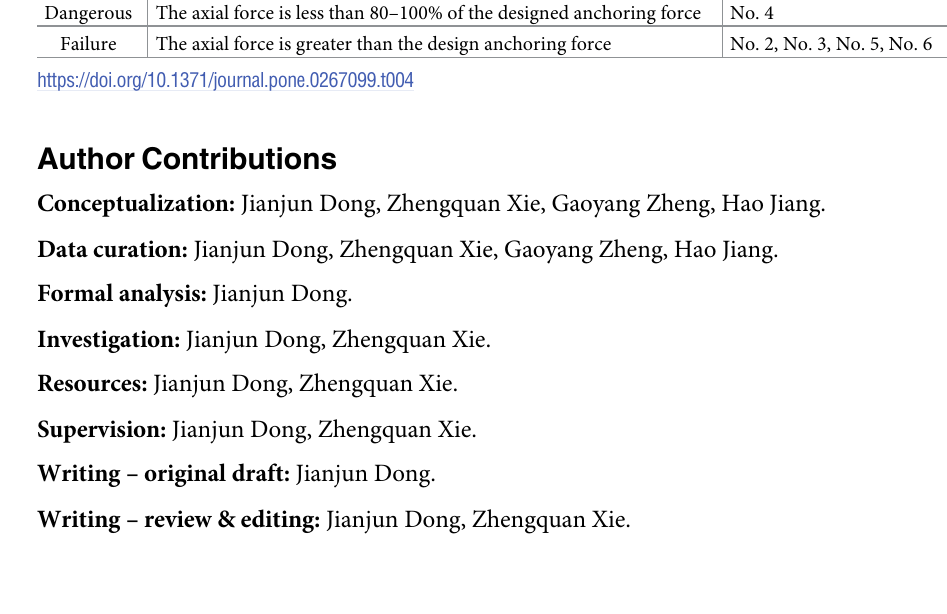
Table 4. Bolt safety status statistics. Bolt status Condition Normal